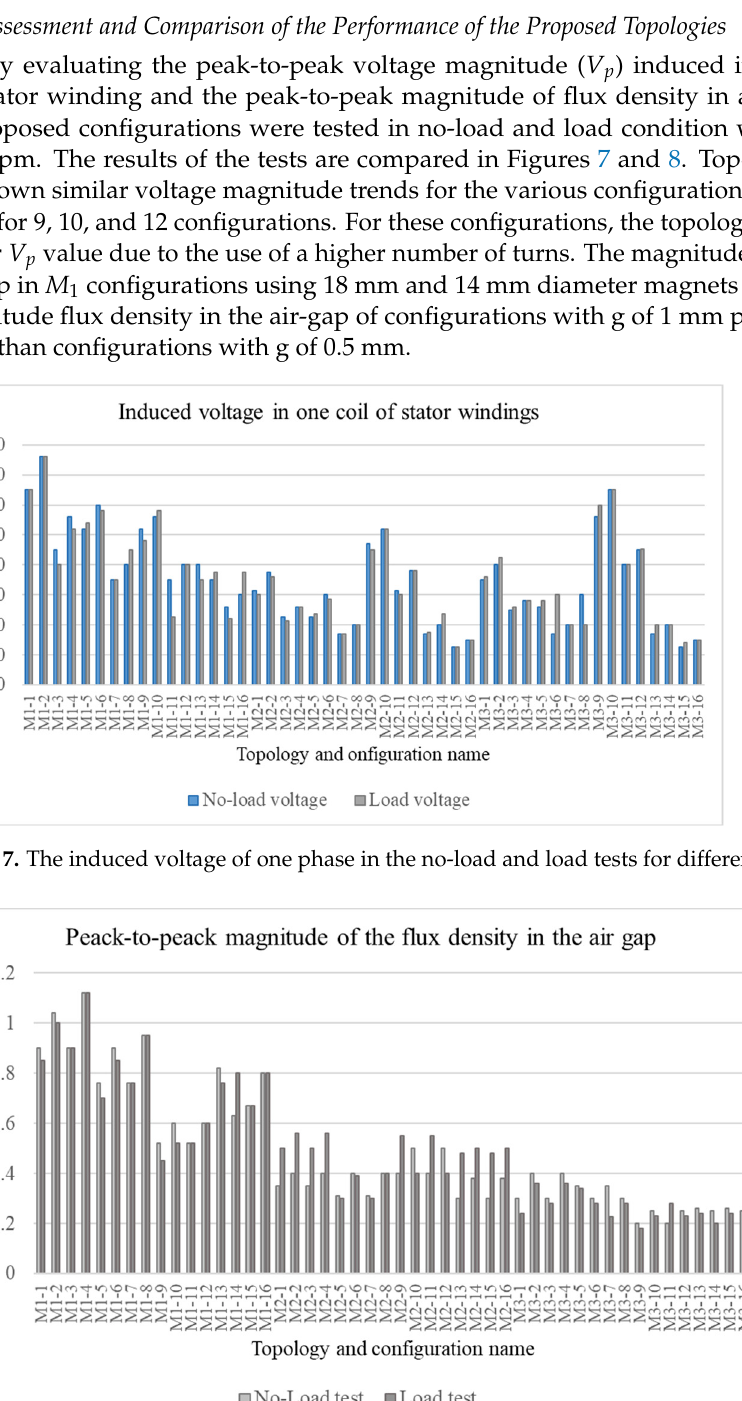
Figure 9. The output power of different topologies and configurations. 4.2. Analysis of the Highest Performance Topology under Different Working Conditions The 10 configurations of M 2 model were designed with a N-S layout of the PMs, which provides a balanced flux path within the AFPMGS core. The magnetic flux density vector path is shown in Figure 10. The magnetic flux density generated during the working conditions of the AFPMGS is higher inside the coil and assumes values of 0.5– 1.23 T without saturating any component; besides part of the flux is leakage on the external surfaces of the stator and rotor and assumes values of about 0.2–0.5 T.